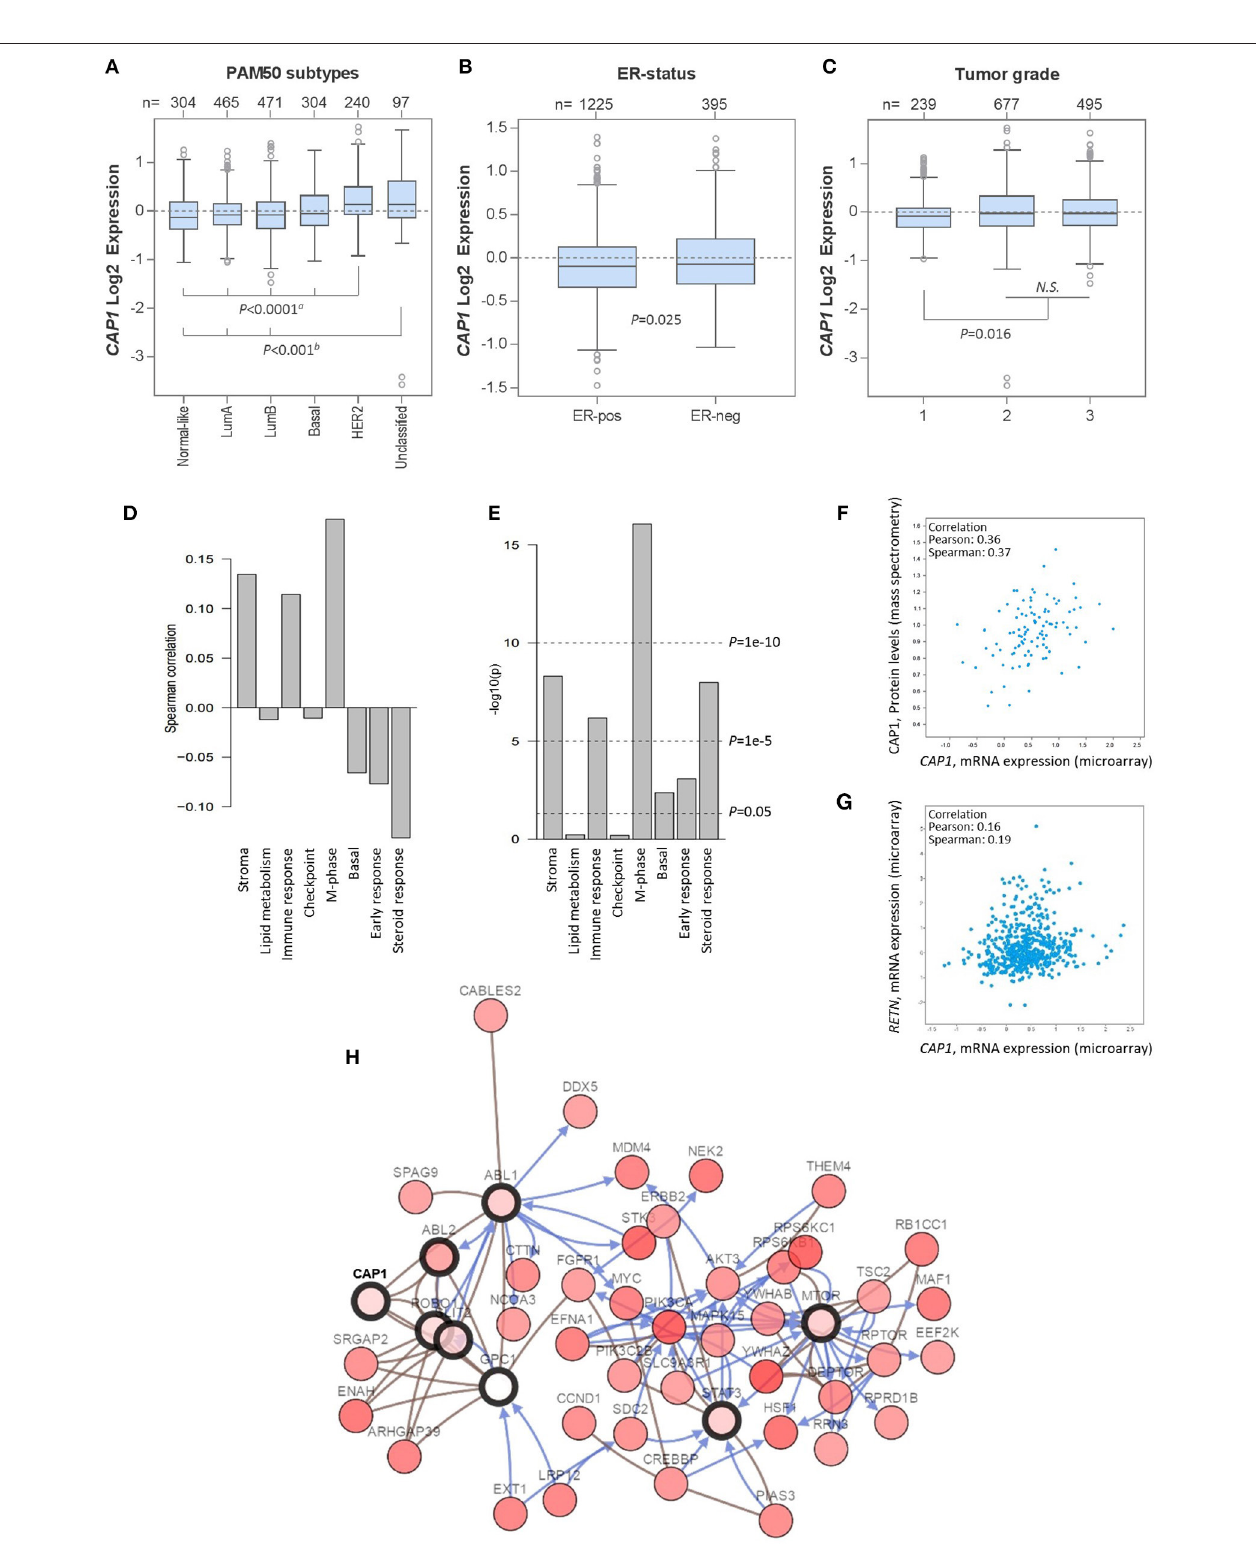
FIGURE 6 | CAP1 mRNA expression across primary breast tumors . Box plots showing CAP1 gene expression among all breast tumors within the 1,881-sample GOBO breast cancer data set stratified according to (A) PAM50 subtypes, with P -values calculated by one-way ANOVA with Tukey’s post-hoc test, (B)